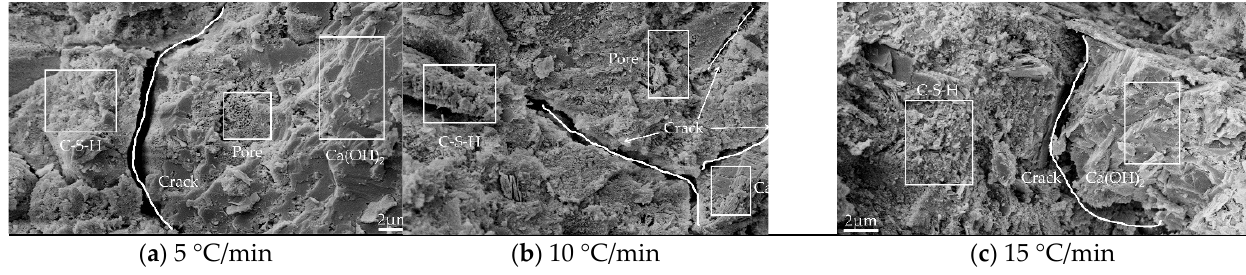
Figure 10. Microtopography and pore structure images of mortar heated (500 °C): ( a ) 5 °C/min; ( b ) 10 °C/min; ( c ) 15 °C/min. ( a ) 5 °C/min ( b ) 10 °C/min ( c ) 15 °C/min Figure 11. Microtopography and pore structure images of mortar heated (600 °C): ( a ) 5 °C/min; ( b ) 10 °C/min; ( c ) 15 °C/min. 3.3.2. NMR T 2 Spectra and Fractal Analysis The T 2 relaxation time distributions for mortar are shown in Figure 12. The T 2 spec- trum is positively correlated with the amount of pore water content of concrete, i.e., the